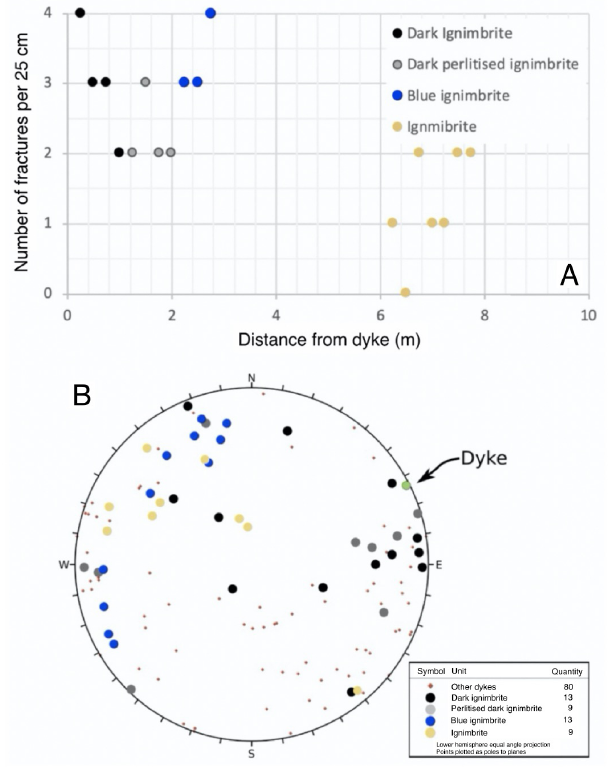
Figure 3: [A] Fracture spacing data recorded at scan- line intersection binned every 25 cm to illustrate frac- ture density as a function of distance from the dyke margin. [B] Stereographic lower hemisphere, equal area projection of fracture orientations planes in the differ- ent rock types including comparison to the orientation of the dyke investigated in this study and other dykes in Hvítserkur measured in the field.